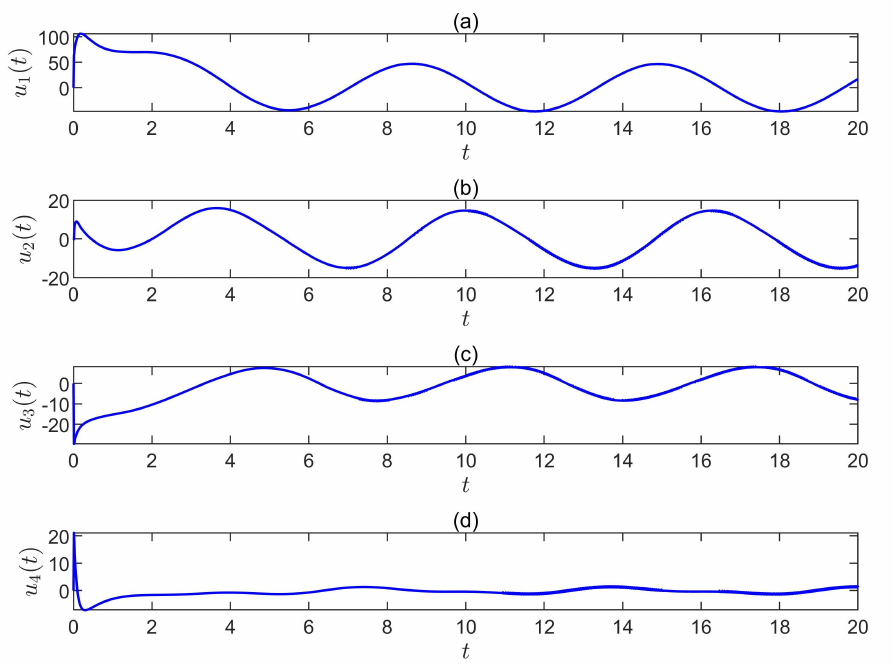
Figure 8. The control input signals of the system: ( a ) the u 1 − t space; ( b ) the u 2 − t space; ( c ) the u 3 − t space; ( d ) the u 4 − t